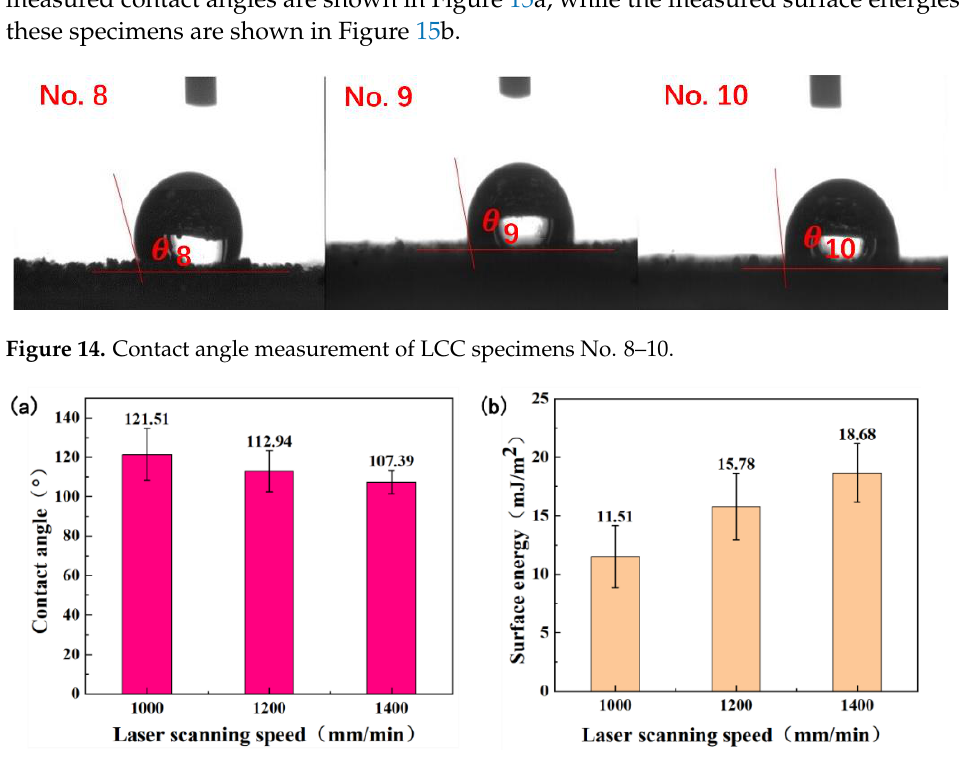
Figure 15. Measured ( a ) contact angle and ( b ) surface energy of LCC specimens No. 8 – 10 with Ni60/TC4 mass ratio of 3/7 and laser cladding power of 1000 W.